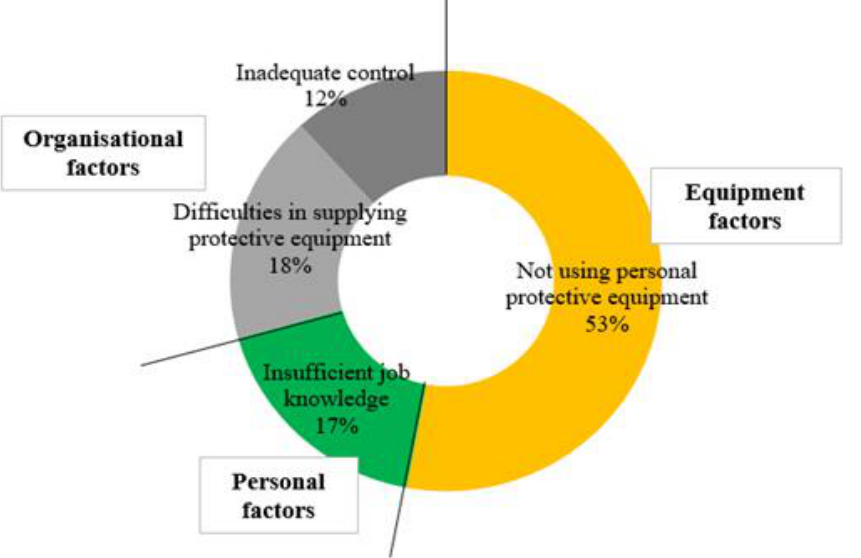
Figure 2. Categories of risk factors influencing the H&S related major NCs (% of all H&S related major NCs).